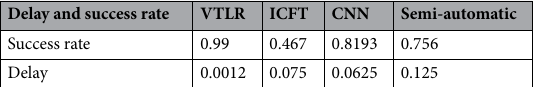
Table 5. Implementation results for the delay and success